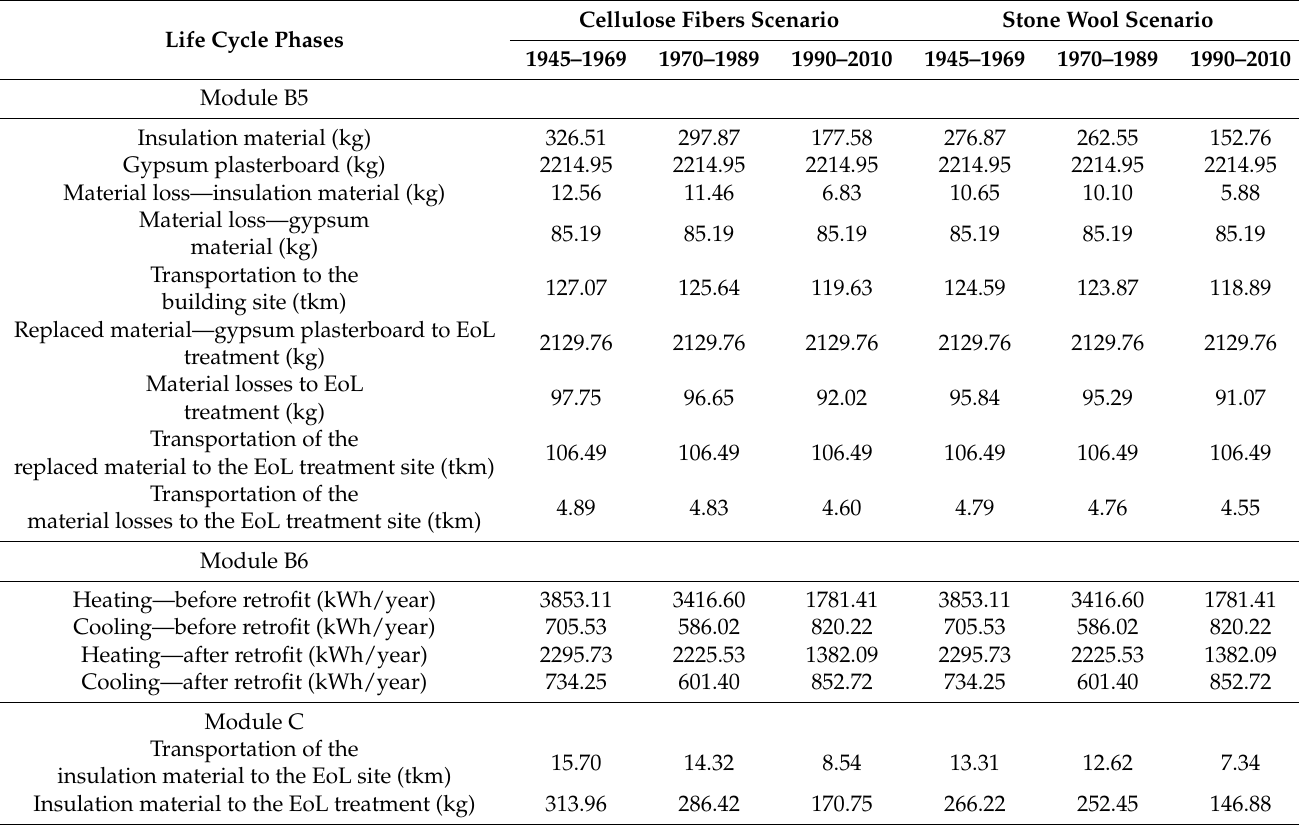
Table 2. Inventory list of materials and processes used for life cycle phases modeling (91.8 m 2 of thermal insulated walls). Life Cycle